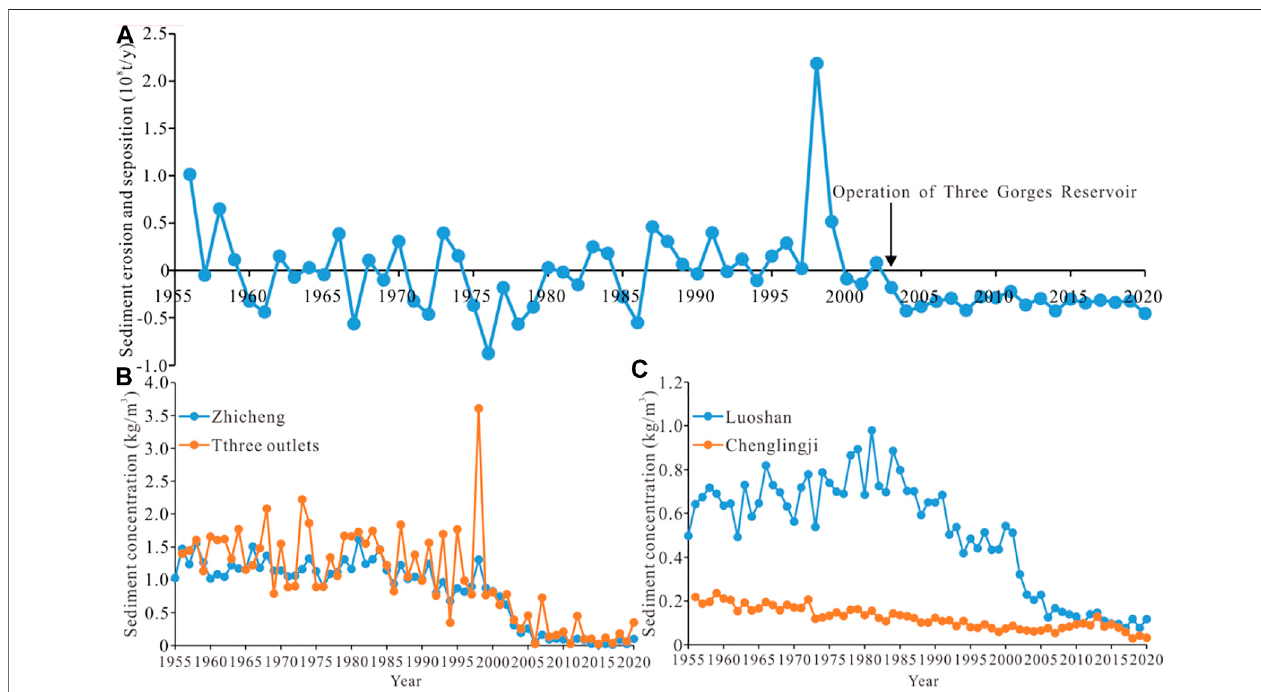
FIGURE6| Sedimentscouring,sedimentconcentration,depositioninJingjiangreachandDongtingLake; (A) Sedimenterosionanddeposition; (B) Comparisonof sediment content in three outlets of Dongting Lake and mainstream of Changjiang River; (C) Sediment content of Chenglingji Hydrological Station and Luoshan Hydrological Station.